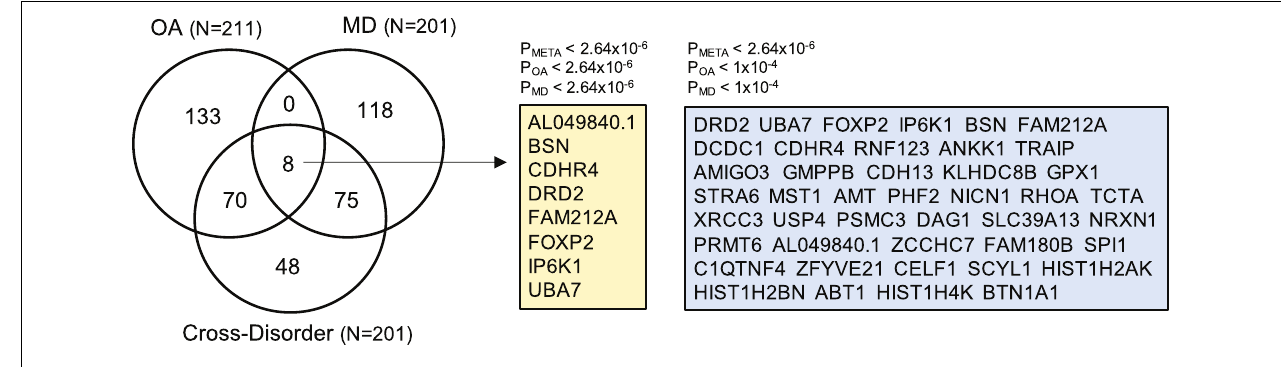
FIGURE 4 | Venn diagram summarizing the overlap of gene-based analysis results from OA, MD, and cross-disorder GWAS. The numbers in the Venn diagram represent the number of shared and/or distinct genes identified as statistically significant in three gene-based association analyses after Bonferroni correction ( p < 2.64e-06). The total number of OA-, MD-, and cross-disorder associated genes are listed in the parentheses. There are eight genes for which all three gene-based analysis showed genome-wide significant association (listed in yellow box). In the right blue box, we list 43 genes, which showed genome-wide significant association in meta-analysis-based gene association analysis, and suggestive association at p < 1e-04 in OA- and MD-specific